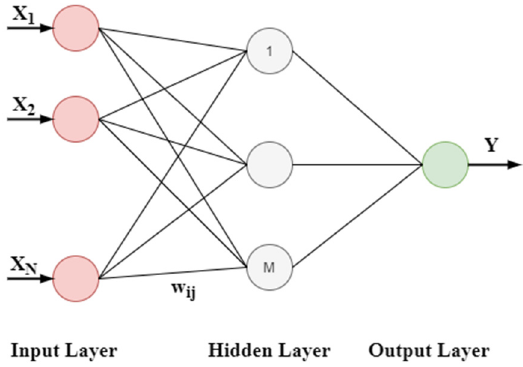
Figure 2. General structure of GFNN based on description contained in [52,53].